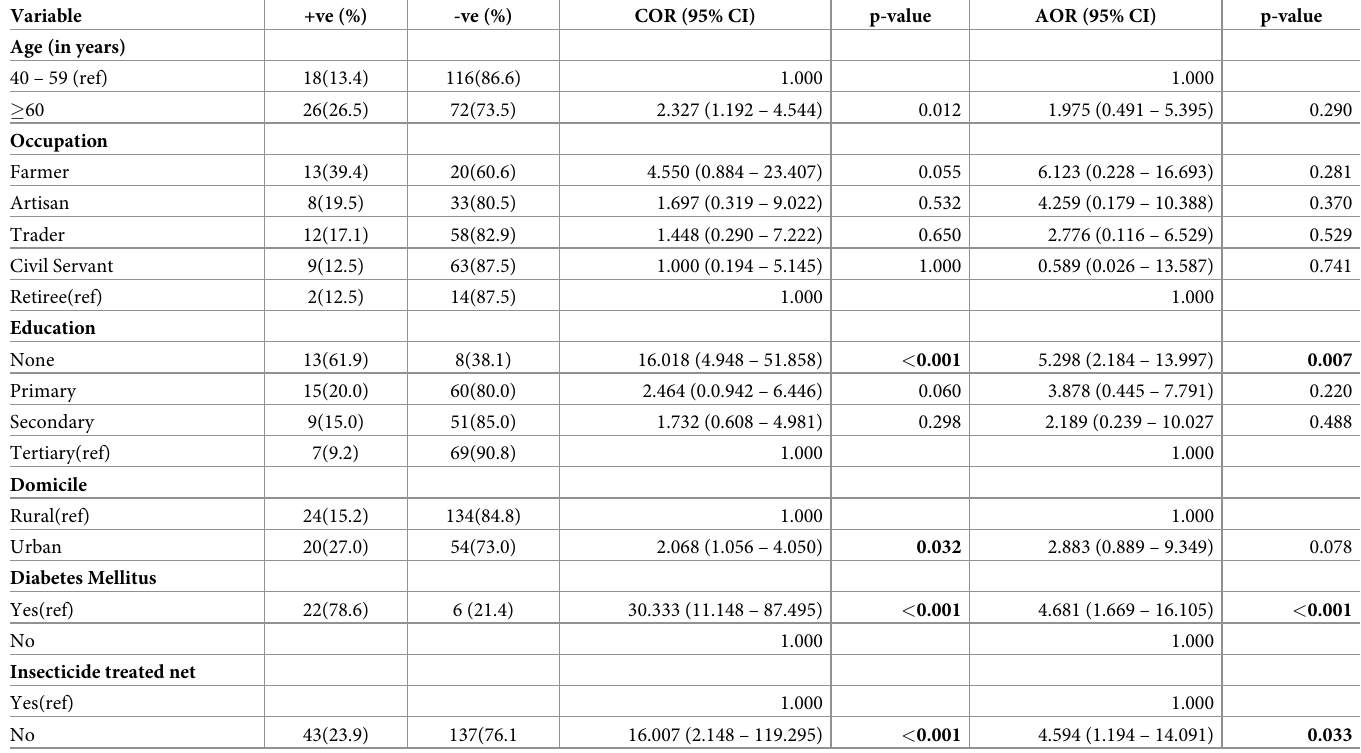
Table 3. Multivariate logistic regression for the significant factors associated with asymptomatic